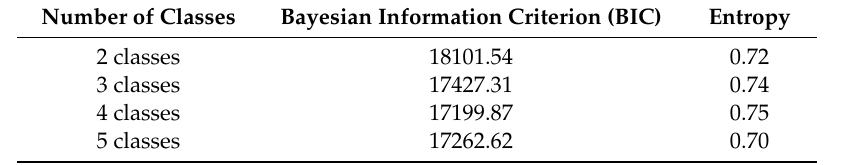
Table 2. Fit indices of the latent class analysis (LCA); values in bold show the best model fit. Number of Classes Bayesian Information Criterion (BIC) Entropy